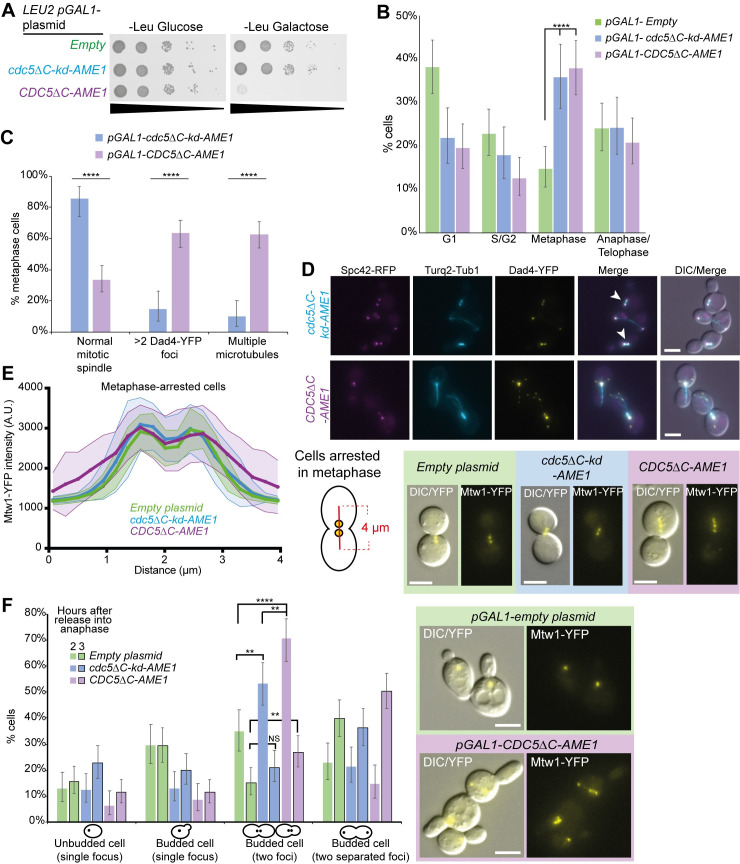
Association of Cdc5 with Ame1 disrupts Mtw1 foci and mitotic progression.(A) 10-fold serial-dilution spot assay showing that pGAL1-driven expression of CDC5ΔC-AME1 prevents growth whereas cdc5ΔC-kd-AME1 does not. (B) Cell-cycle analysis as in Fig 3C but with Dad4-YFP Turq2-Tub1 cells (T692) also containing RFP-tagged SPB (Spc42-RFP) and expressing pGAL1-CDC5ΔC-AME1 (n = 223), pGAL1-cdc5ΔC-kd-AME1 (n = 173) or empty plasmid (n = 249). Cell expressing either CDC5ΔC-AME1 or cdc5ΔC-kd-AME1 were significantly increased in metaphase compared to empty plasmid control. Fishers exact statistical test; p-values **** = p < 10−6. Error bars indicate 95% binomial confidence intervals. (C) The metaphase cells in (B) were categorized based upon the cell and spindle morphology observed using fluorescence imaging for both pGAL1-CDC5ΔC-AME1 (n = 93), pGAL1-cdc5ΔC-kd-AME1 (n = 62). Normal spindle was categorized as two separated Spc42-RFP and Dad4-YFP foci with microtubule signal in between. Cells expressing CDC5ΔC-AME1 had significantly fewer normal spindles and increased Dad4-YFP foci and microtubules. Fishers exact statistical test; p-values **** = p < 10−4. Error bars indicate 95% binomial confidence intervals. (D) Representative cropped images from the analysis in (C) showing cdc5ΔC-kd-AME1 expressing cells (top) and CDC5ΔC-AME1 expressing cells (bottom). Normal mitotic spindles are indicated with white arrows. Scale bar indicates 5μm. (E) Mtw1-YFP cells (PT63-12B) were arrested in metaphase using Cdc20 depletion and the Mtw1-YFP fluorescence intensity was quantified along the axis of the mitotic spindle after inducing CDC5ΔC-AME1 or controls for two hours (see S5A Fig for further description of experimental setup). A 4 μm line with 19 points (illustrated in the inset on the right) was used to include background signal and to cover the spread YFP signal phenotype in cells expressing CDC5ΔC-AME1 (40 randomly selected mitotic spindles were measured for each condition). The shadowed area indicates standard deviation. Cells expressing CDC5ΔC-AME1 have a more dispersed arrangement of Mtw1-YFP, as indicated by the flatter profile. Representative cropped images are shown on the right. (F) The metaphase-arrested cells in (E) were released into anaphase and imaged two and three hours later. Two hours after anaphase release (non-outlined bars) cells expressing CDC5ΔC-AME1 (n = 129) were still arrested in metaphase compared to cdc5ΔC-kd-AME1 (n = 154) and empty plasmid (n = 149) controls and displayed abnormal Mtw1-YFP foci shown on the right. Three hours after anaphase release (black-outlined bars) there was no statistical difference between cells expressing CDC5ΔC-AME1 (n = 220) and cdc5ΔC-kd-AME1 (n = 190) but cells containing empty plasmid control (n = 198) showed significantly reduced number of budded cells with two kinetochore foci compared to CDC5ΔC-AME1. Fishers exact statistical test; p-values ** = p < 0.005, **** = p < 10−5. Error bars indicate 95% binomial C.I. All scale bars indicate 5μm.